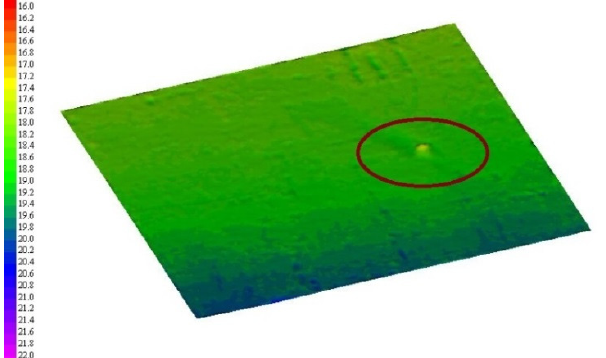
Figure 13. The 3D topographic result of a buried shipwreck.